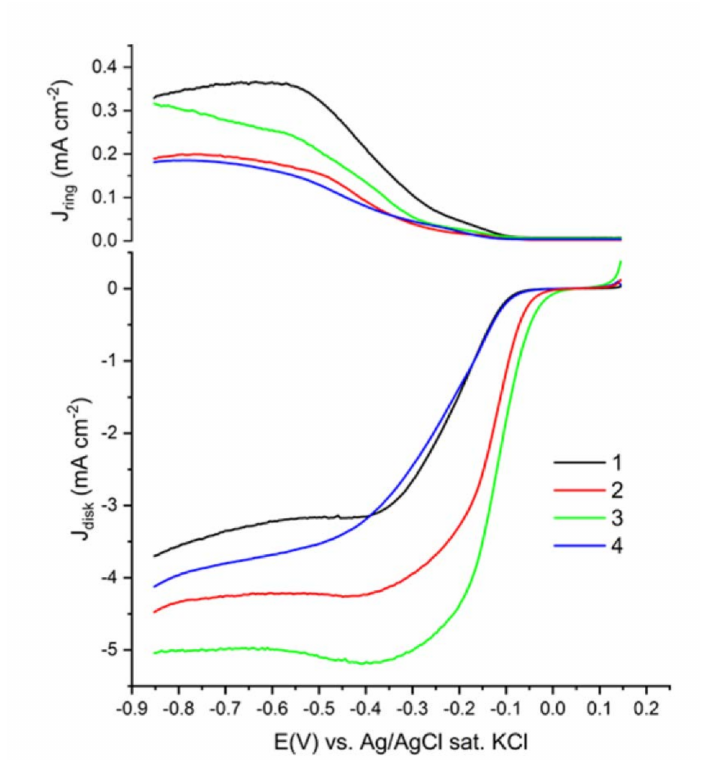
Figure 5. Rotating ring disk electrode (RRDE) ring ( top ) and disk ( bottom ) currents showing ORR activities of the investigated samples. Sample numbers 1–4 refer to Table 2. Rotation rate: 1600